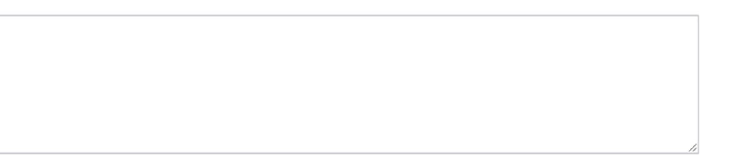
Fig 2. The publication